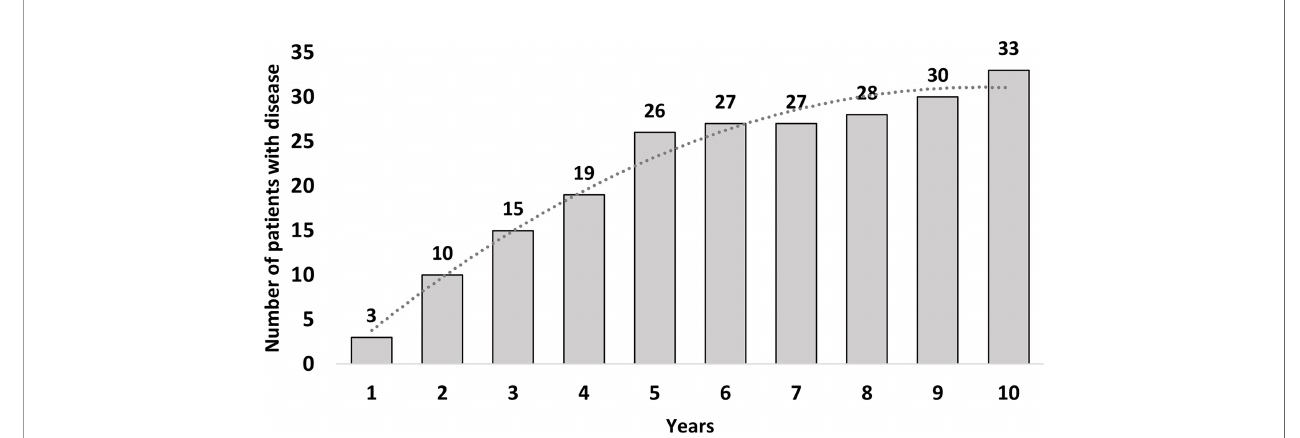
FIGURE 2 | Number of patients showing metastases in relation to the years after the end of surgery.